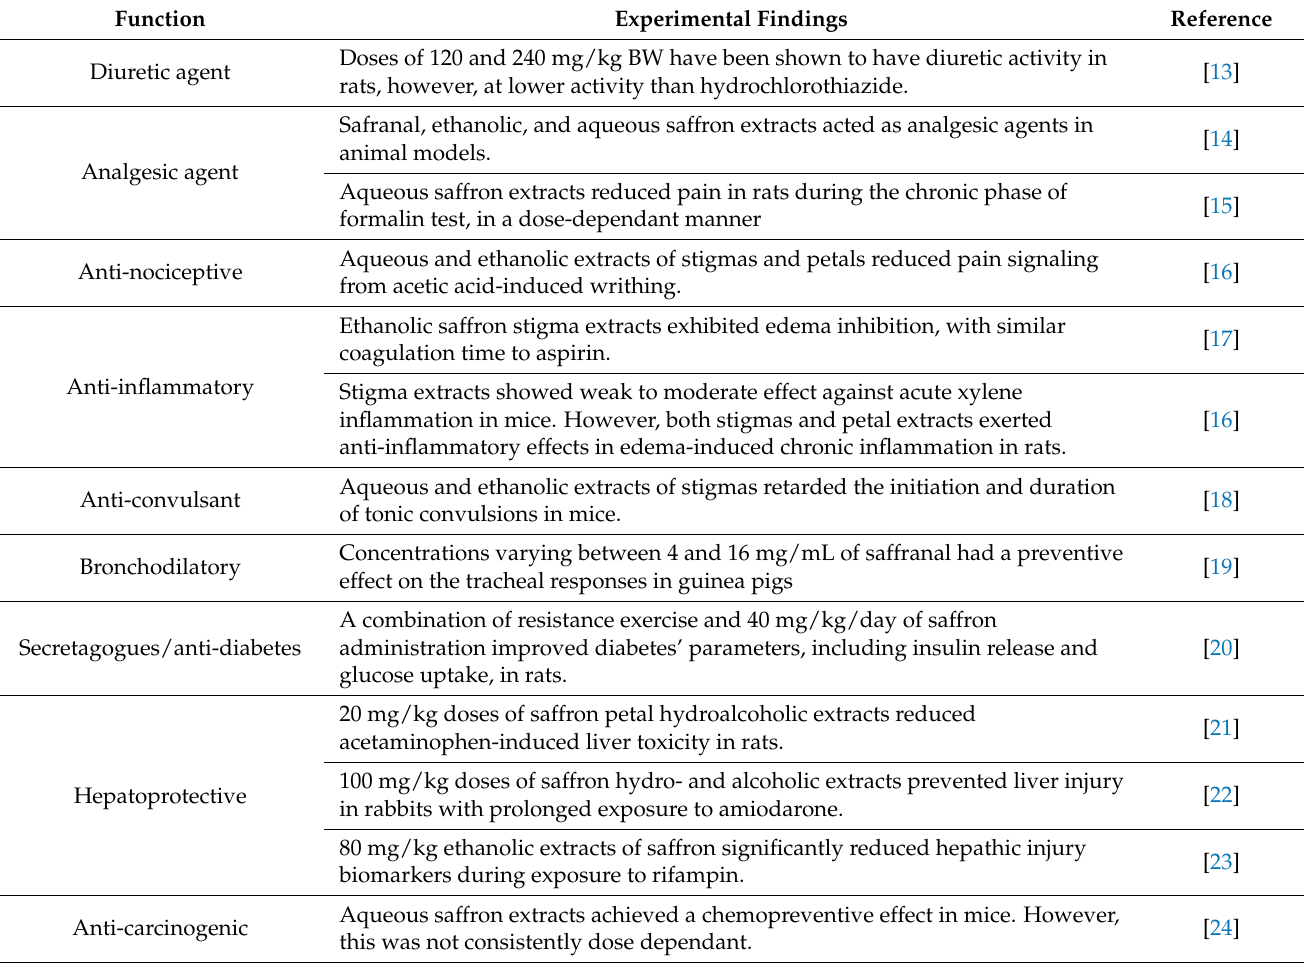
Table 1. Reported functions of saffron and its extracts in experimental trials. Experimental Findings